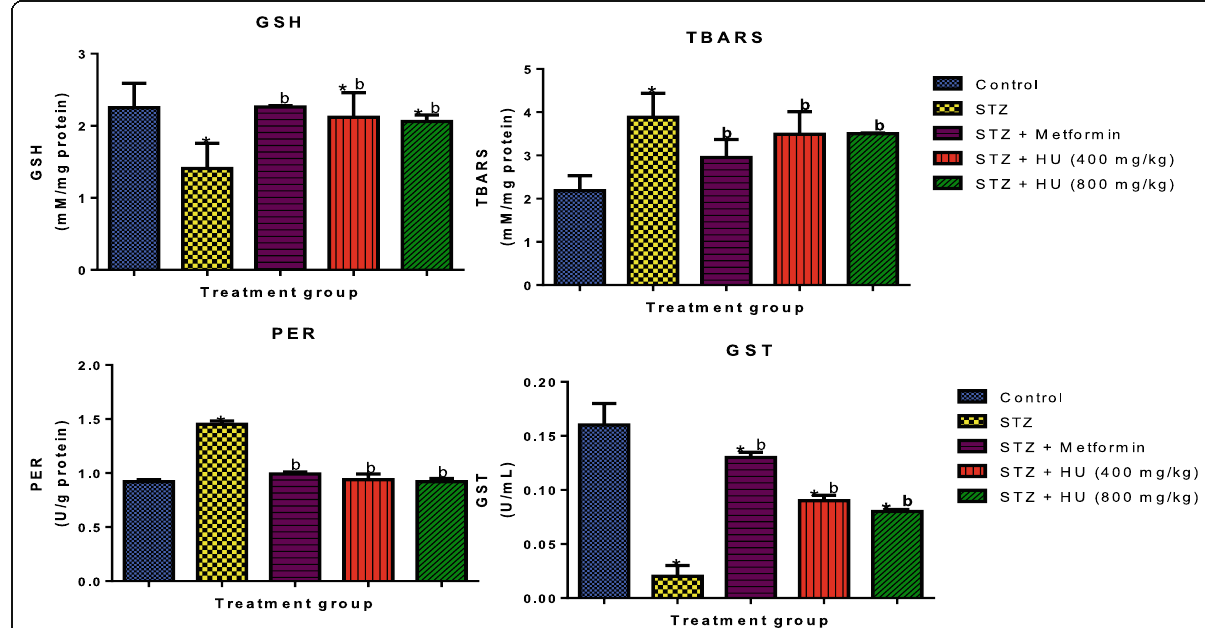
Fig. 3 Oxidative marker levels in the spleen. Superscripts * a b represent values that are significantly (p < 0.05) different from negative control, metformin treated group and positive control respectively. GSH, TBARS, PER, GST, STZ and HU represents reduced glutathione, thiobarbituric acid reactive substances, peroxidase, glutathione-s-transferase, streptozotocin and Hunteria umbellata